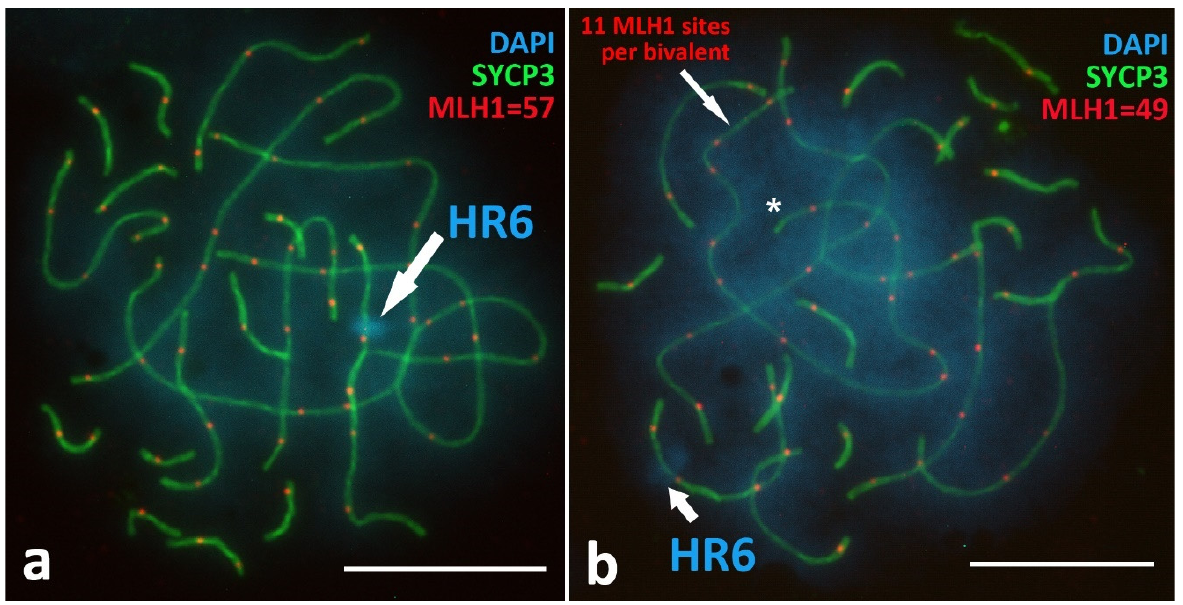
Figure A3. Pachytene stage, V. berus spermatocyte I. Immunodetection of crossing-over marker, MLH1 protein (red). ( a ) 57 MLH1 sites in one SC-spread. ( b ) 49 MLH1 sites in one SC-spread and 11 MLH1 sites on one macrobivalent 1 (asterisk). Heterochromatin region on the bivalent 6 (HR6) is indicated. Axial elements of chromosomes are immunostained with antibodies against the SYCP3 protein (green). Chromatin stained with DAPI (blue). Bar—10 μ m.